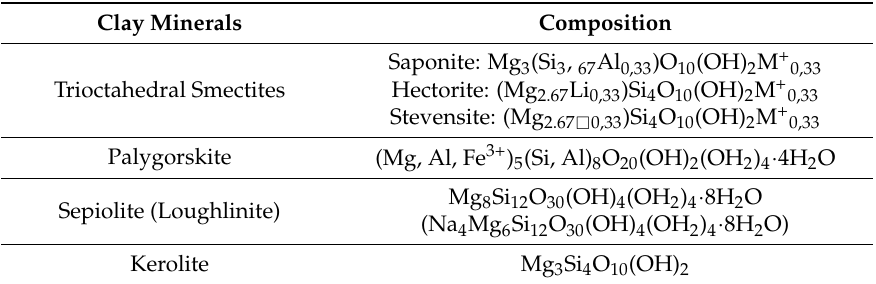
vacancies in the octahedral sheet of